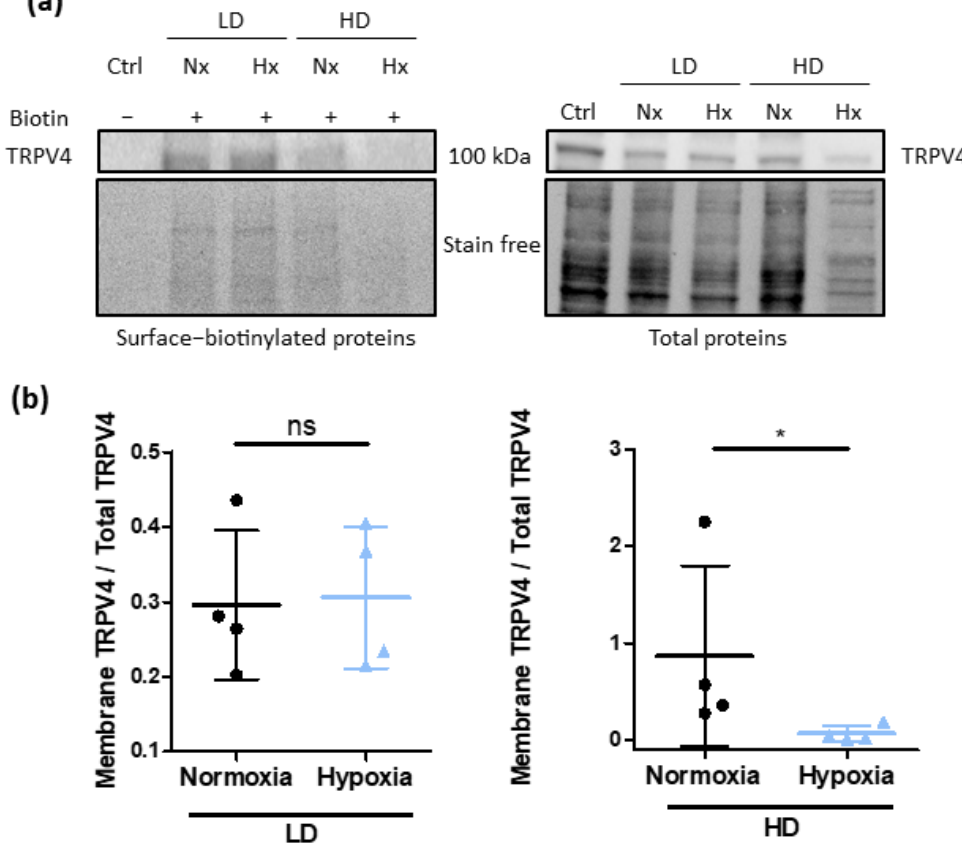
Figure 7. Cell confluence reduces plasma membrane expression of TRPV4 channels in TRPV4-transfected HEK293T cells under hypoxia. ( a ) Representative Western blots showing the presence of TRPV4 surface-biotinylated and total proteins from HEK293T cells transfected with TRPV4 WT and cultured at low (1 × 10 4 cells/cm 2 ) and high density (3 × 10 5 cells/cm 2 ) under normoxia (21% O 2 ) or hypoxia (1% O 2 ) for 48 h. Samples without biotin were used as negative control. ( b ) Membrane TRPV4/Total TRPV4 ratio was evaluated for each condition with stain free normalization. Data are expressed as mean value ± SD. Significant difference is indicated by one asterisk when p < 0.05 and ns indicates a non-significant difference, Mann–Whitney test.